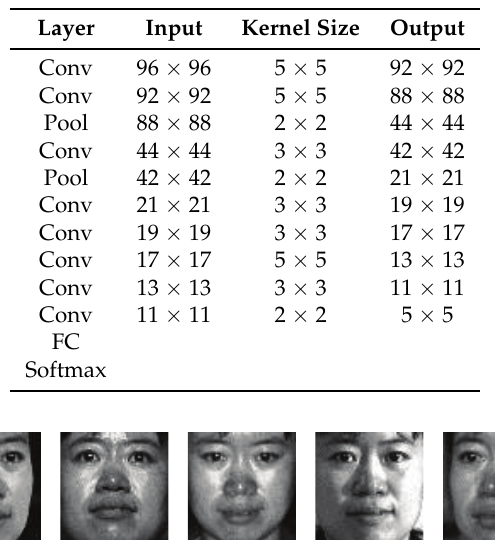
Table 7. The structure of convolutional neural network.